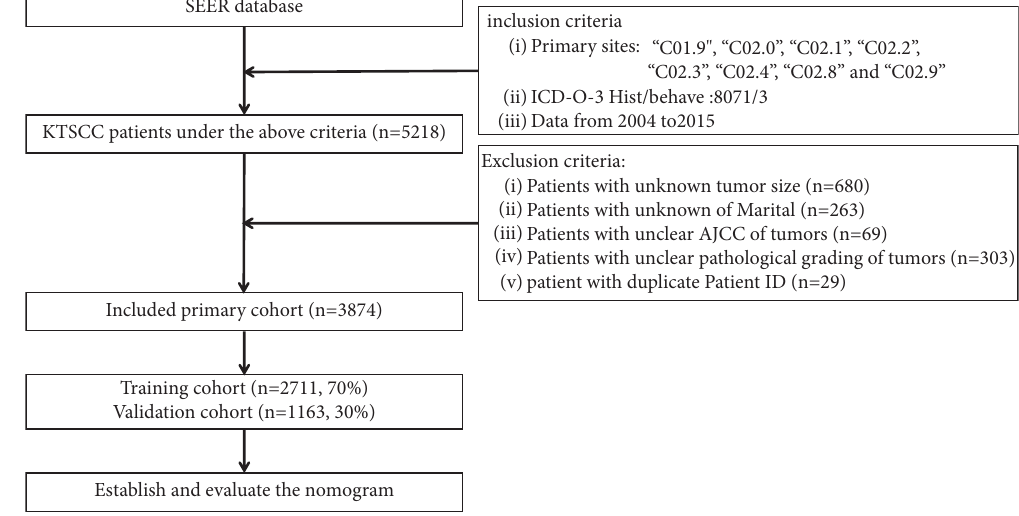
Figure 1: Research